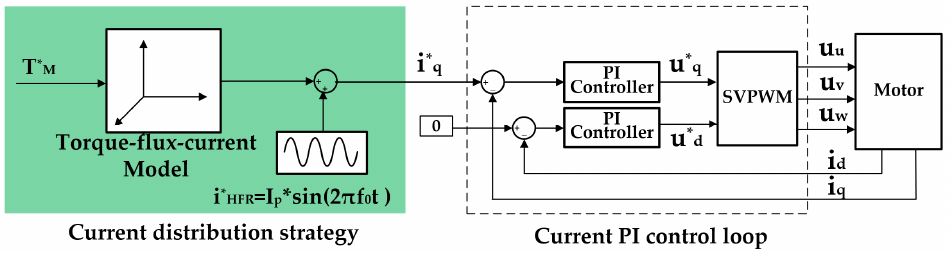
Figure 6. Realization of HFR perturbation current based on the conventional control method.